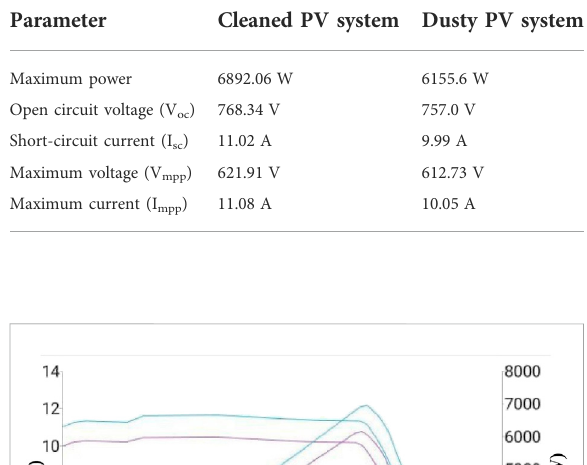
TABLE 9 Parameters of the photovoltaic systems for December.